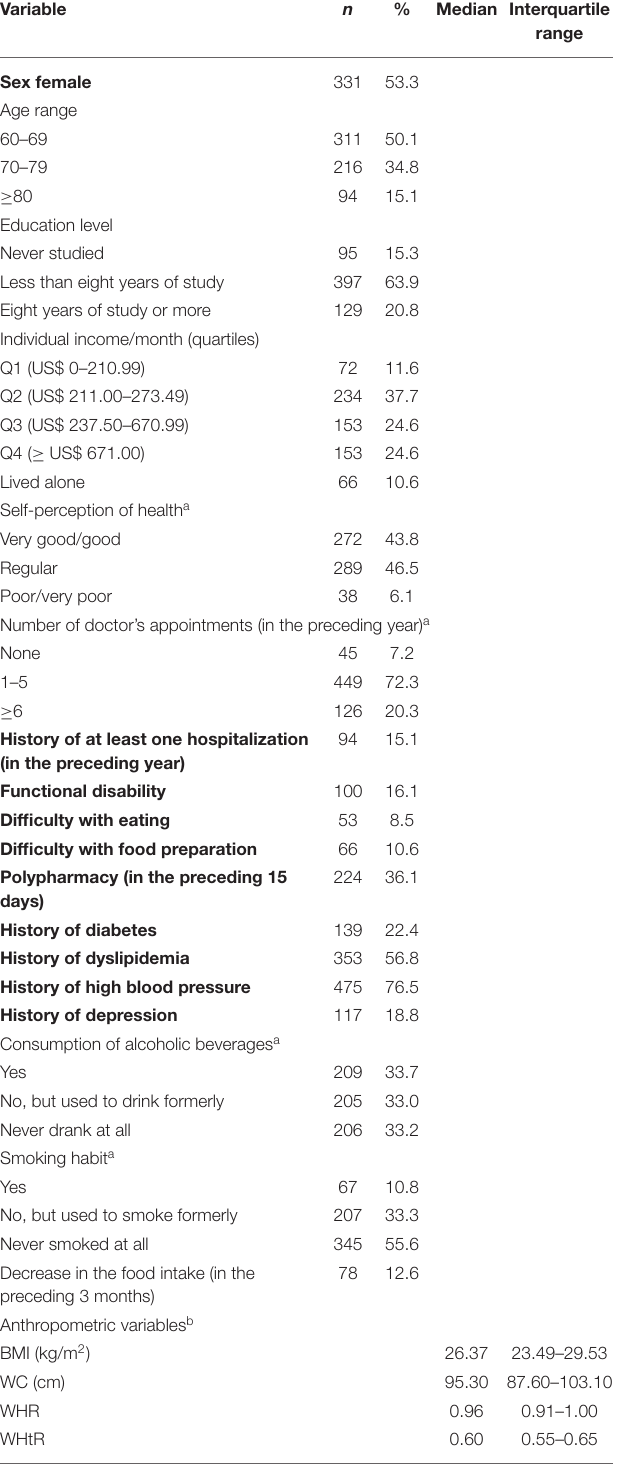
TABLE 2 | Socioeconomic characteristics, health and use of health services, lifestyle, and anthropometric indicators in the older adult sample, Viçosa, State of Minas Gerais, Brazil, 2009 ( n = 621).